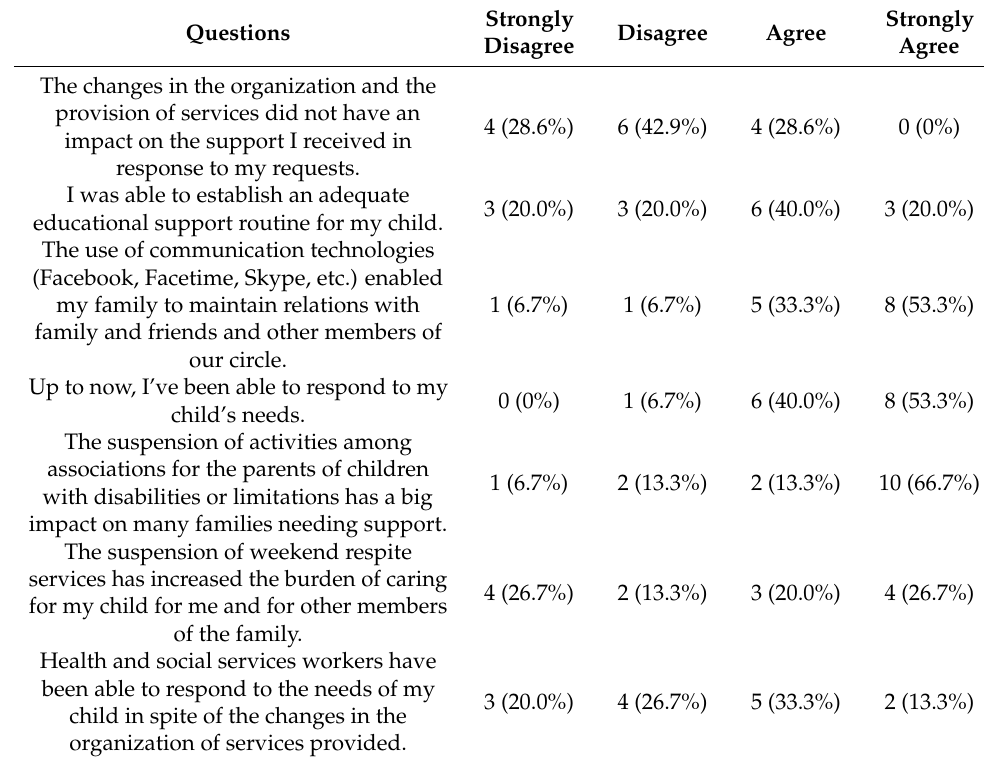
Table 3. Answers of 16 parents of children with disabilities related to their parental role during the pandemic in Quebec province (Canada) 1